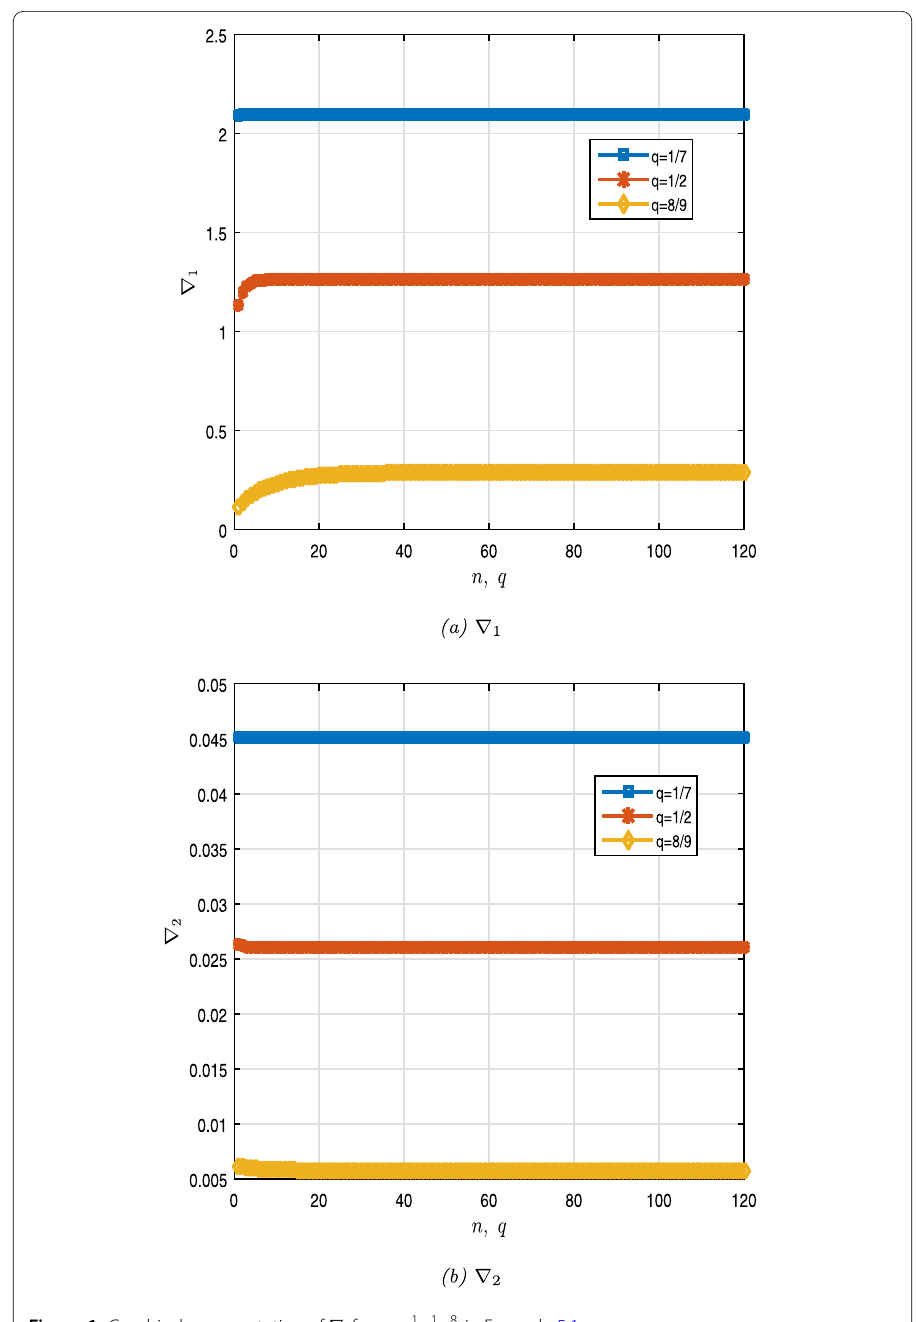
Figure 1 Graphical representation of ∇ i for q = 1